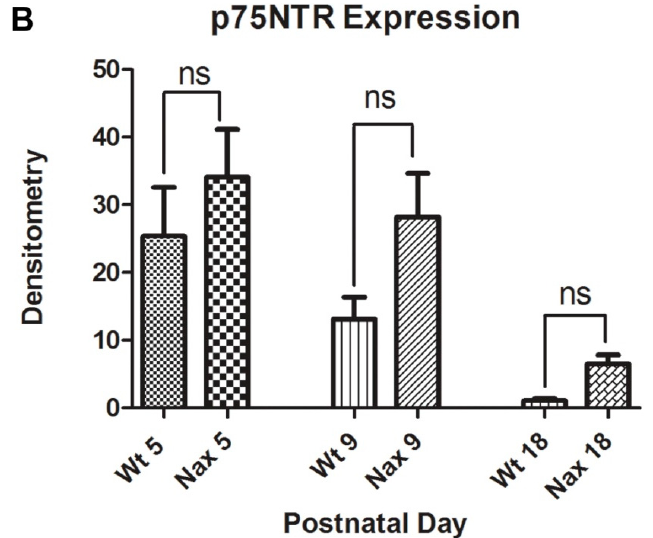
Figure 5. Western blot analysis of p75NTR expression during cerebellar development at P5, P9 and P18. This experiment was repeated over three different litters for each postnatal days in wt and nax siblings (P5, P9 and P18, wt; n = 9 and nax ; n = 9). ( A ) Immunoblots of total cell lysate from wt sibling and nax mouse cerebellum indicate significant down-regulation in the wt sibling and also in the nax cerebellum from early postnatal development to P18. However, there is no considerable difference in p75NTR expression between the wt and nax cerebellum, despite the higher p75NTR expression in nax compared with wt. ( p > 0.05). Protein loading was confirmed using GAPDH ( n = 18); ( B ) The data in the bar graph are presented as the mean ± SEM, and statistical analysis was performed using Kruskal-Wallis test followed by Dunnett’s multiple comparison test using Mann-Whitney test. Abbreviation: ns, not significant.